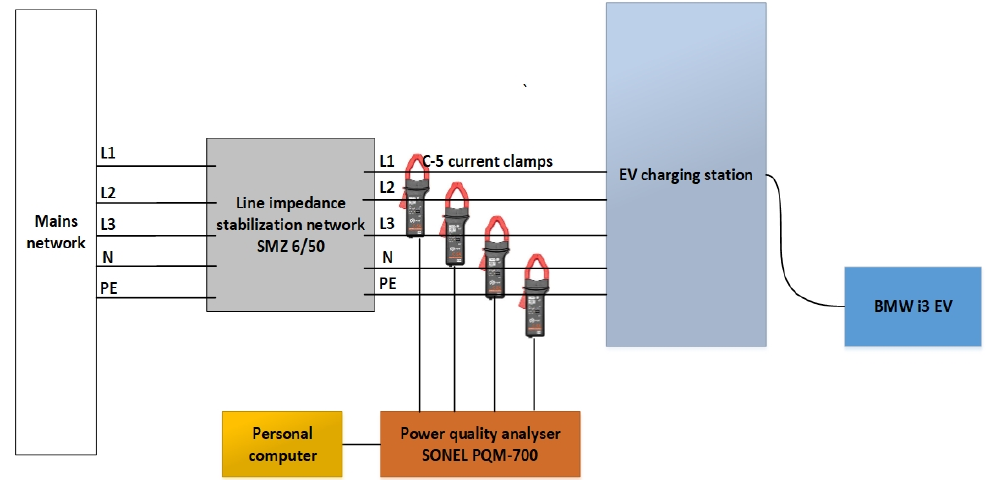
Figure 3. The laboratory setup for harmonic current emission measurements.